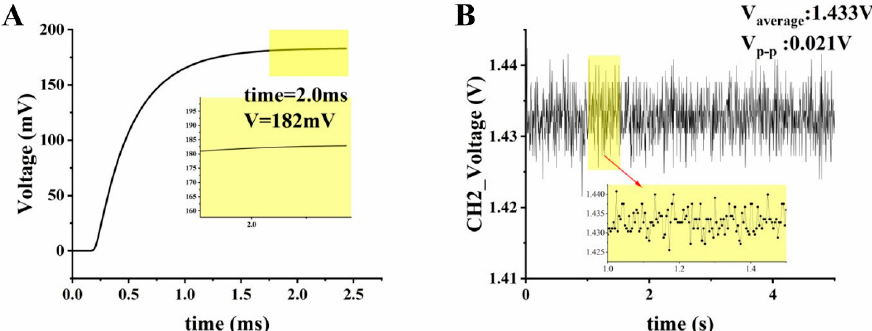
Figure 5. LED stability test result: ( A ) Multisim simulation of voltage value across the LED current sampling resistor; ( B ) oscilloscope waveform of voltage value across the LED current sampling resistor.